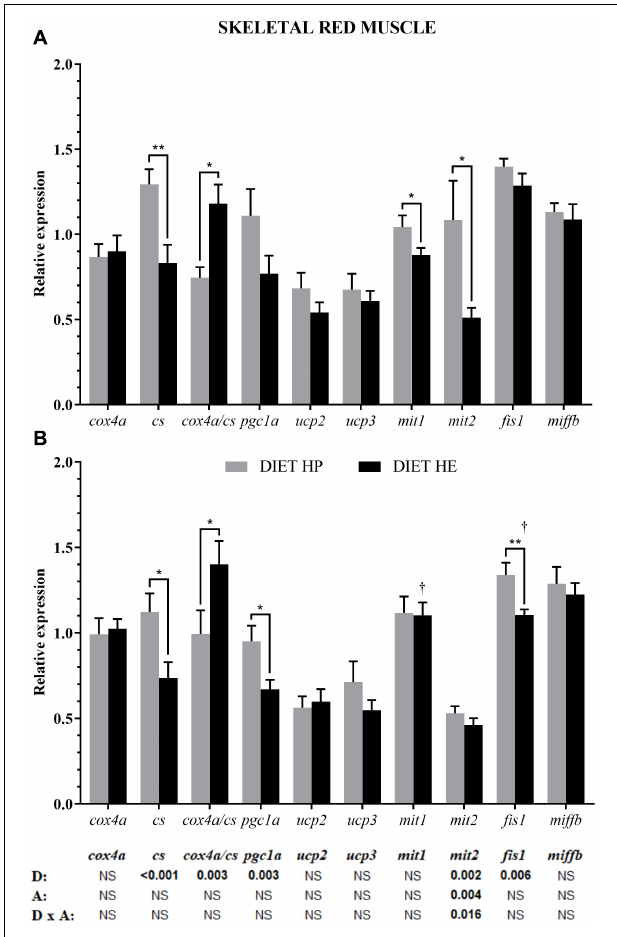
FIGURE 3 | Relative gene expression of the enzymes in energy metabolism, markers of mitochondrial biogenesis and markers of mitochondrial dynamics in the red skeletal muscle of gilthead seabream fed the HP or HE diet under conditions of voluntary swimming (A) or sustained swimming (B) . Data are shown as the mean ± SEM ( n = 12 for VS and n = 16 for SS conditions). The factorial statistical analysis was assessed by two-way ANOVA and the p -values of the diet (D), swimming activity (A) and the interaction (D × A) are displayed at the bottom of the figure. Pairwise comparisons were assessed by unpaired Student’s t -test. ∗ p < 0.05 and ∗∗ p < 0.01 between diet groups (HP and HE); † p < 0.05 between swimming activity groups (VS and SS).